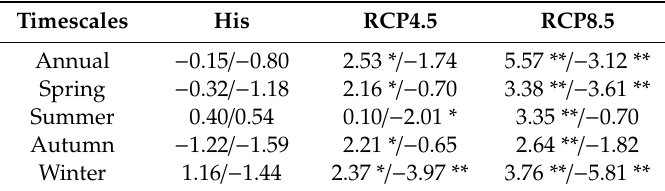
Table 4. Mann–Kendall test values of the annual and seasonal series of SPI and HI historically and in the